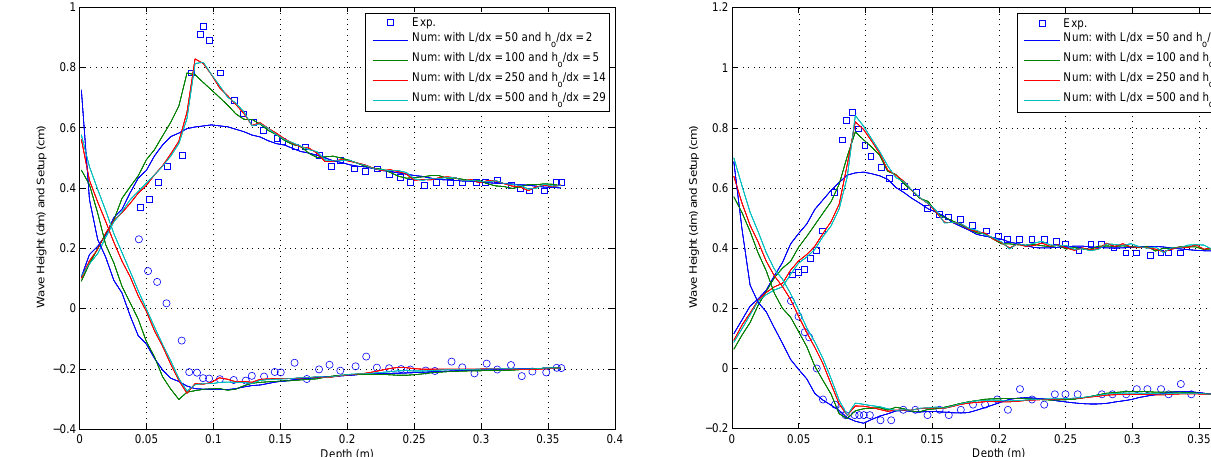
Fig. A1. Computed and measured wave heights and setup for the Hansen and Svendsen case 031041 ( kh o = 0 . 369, H/h o = 0 . 12).